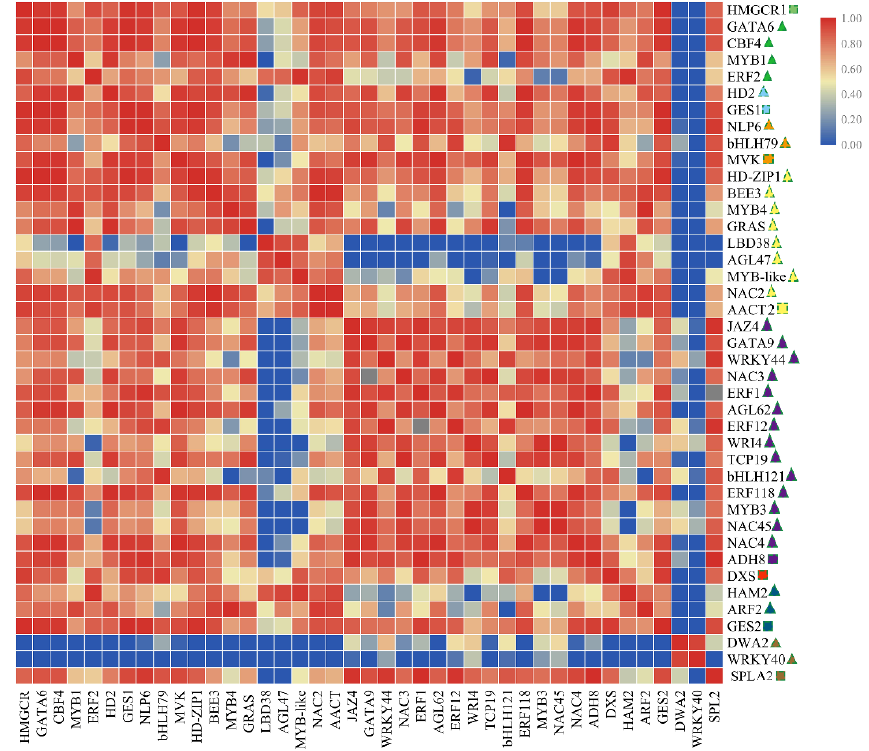
Figure 7. The matrix correlation of genes and TFs involved in volatile biosynthesis (these genes and TFs expression in F1 generation are higher than parental lines). The heatmap drawing was conducted by correlation between genes analyzed by the Spearman test using SPSS 17.0 software and visualized by the TBtools software. Square indicates structural gene; Triangular indicates transcription factors; The same color indicates the same expression pattern in four tea tree.